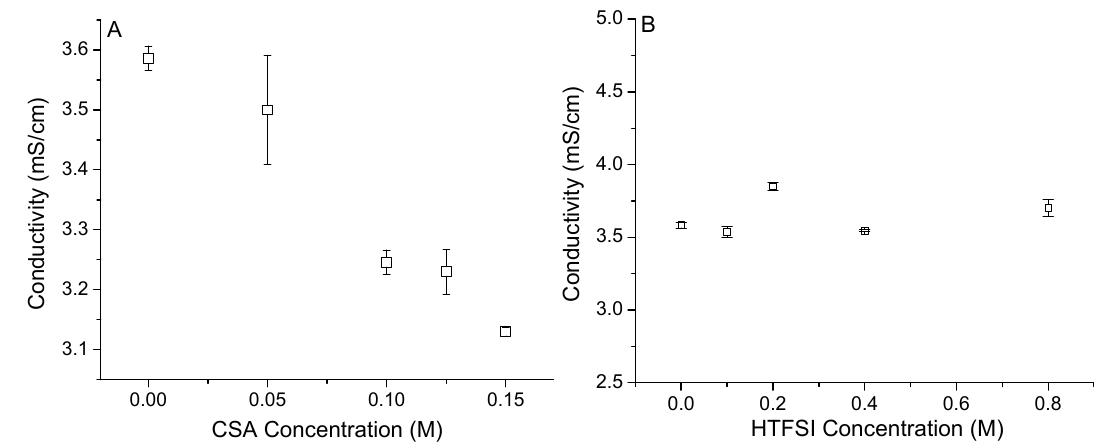
Figure 10. Conductivity of CSA solutions in BMIBF 4 ( A ) and HTFSI solutions in BMIBF 4 ( B ).